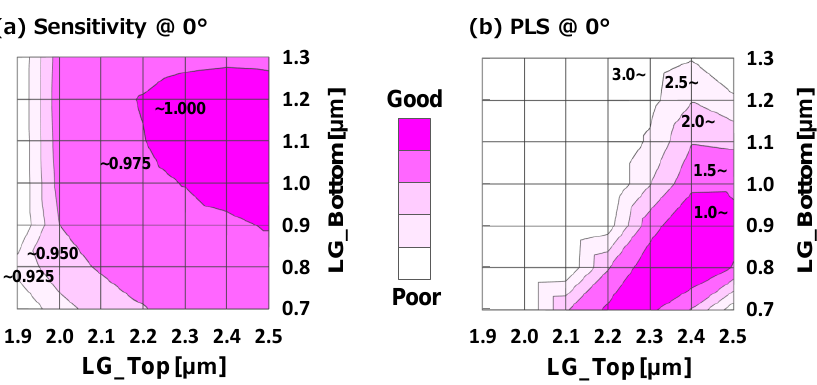
Figure 8. Simulated ( a ) sensitivity and ( b ) PLS results of light guide top and bottom diameter dependence.